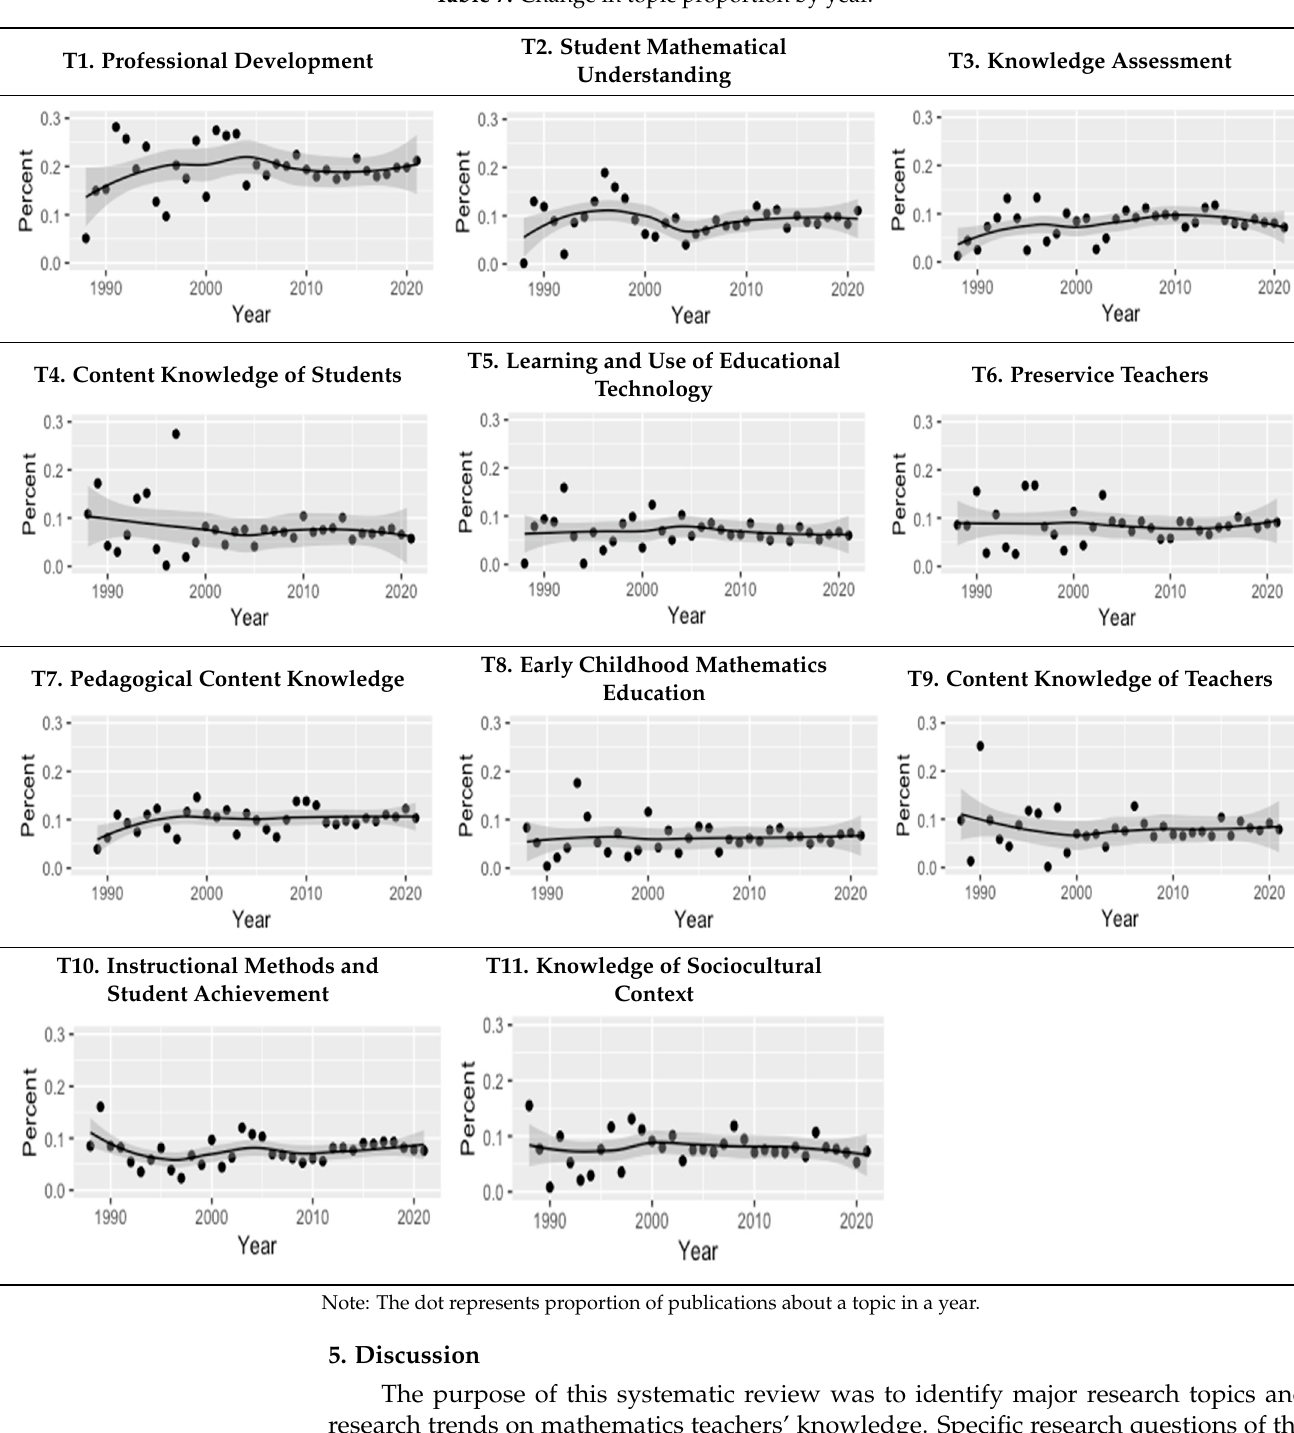
Table 7. Change in topic proportion by year.